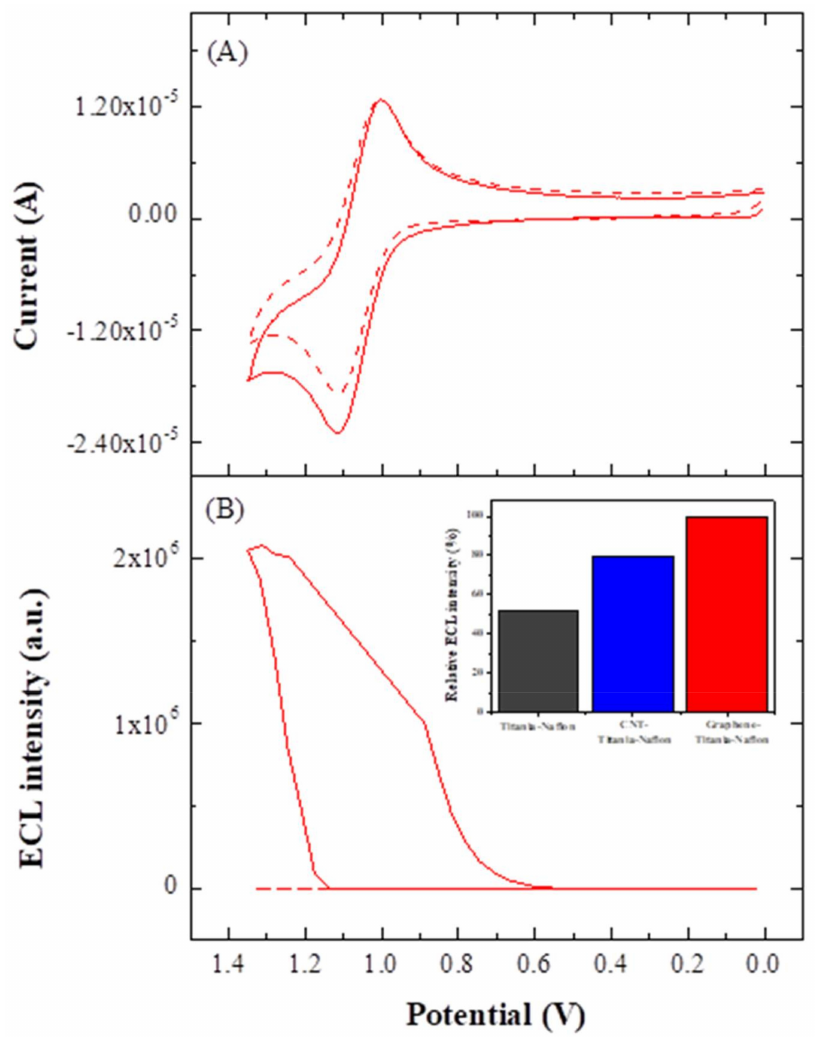
Figure 4. Cyclic voltammograms ( A ) and ECL-potential plots ( B ) acquired by the present ECL sensor based on graphene-titania-Nafion composite without (dashed line) and with (solid line) the presence of 0.5 mM TPA in 0.05 M PBS (scan rate = 100 mV/s). Inset in Figure 4B: Relative ECL response obtained by the ECL sensors based on titania-Nafion composite (black), graphene-titania-Nafion (red), and CNT-titania-Nafion composite (blue) under the same experimental conditions. As 0.5 mM TPA was introduced in 0.05 M PBS, the oxidation current of Ru(bpy)